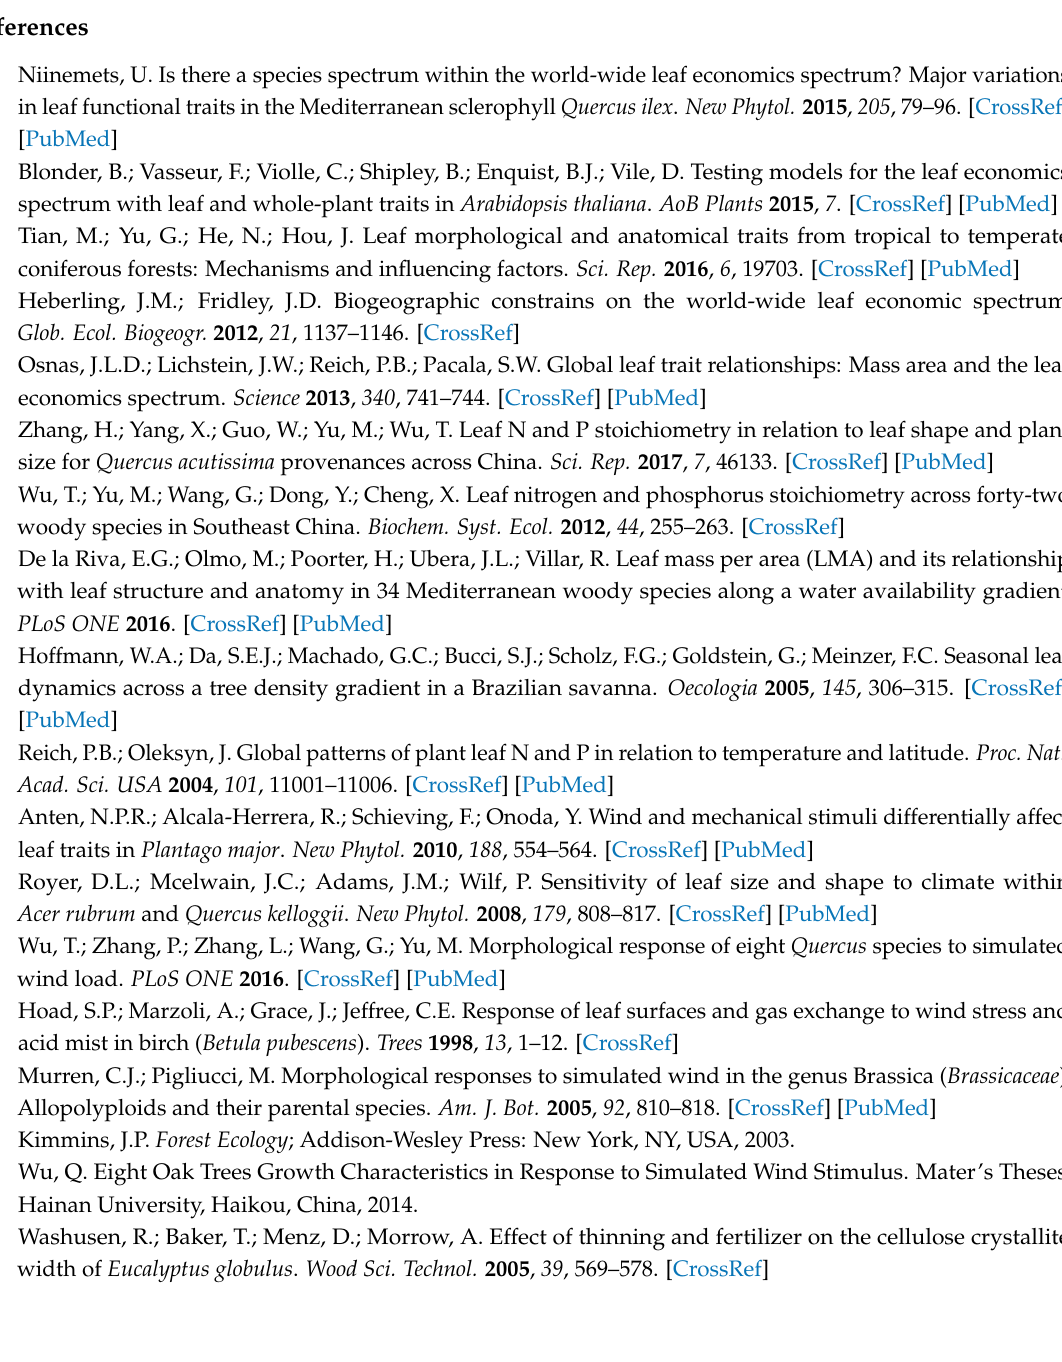
PNUE = Pn/leaf N concentration; PPUE = Pn/leaf P